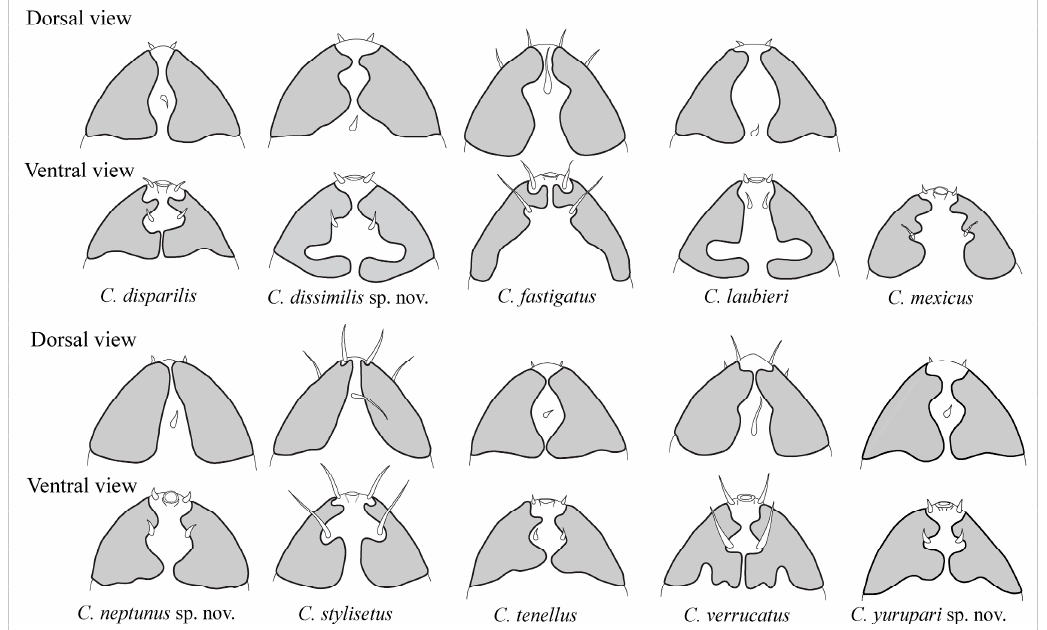
Figure 5. Drawings of secondary clavae of all Coronarctus species ( C. tennellus , redrawn from Renaud- Mornant [26]; C. disparilis , C. fastigatus , C. laubier,i and C. stylisetus , redrawn from Renaud-Mornant [20]; C. mexicus , redrawn from Romano [24], dorsal view not provided , C. verrucatus redrawn from Hansen [22]; C. dissimilis , C. neptunus, and C. yurupari are original